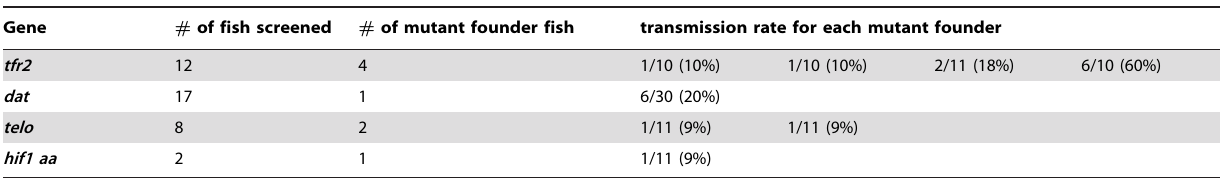
Figure 3. Frequencies and sequences of ZFN-induced mutations in somatic zebrafish cells. For each gene targeted by ZFNs, the wild-type sequence is shown at the top with ZFN binding sites marked. Deletions are indicated by grey highlighted red dashes and insertions by blue highlighted lower case blue letters. The number of times each wild-type mutant allele was isolated is shown in brackets. doi:10.1371/journal.pone.0004348.g003 Table 2. Frequencies of mutations from founder analysis